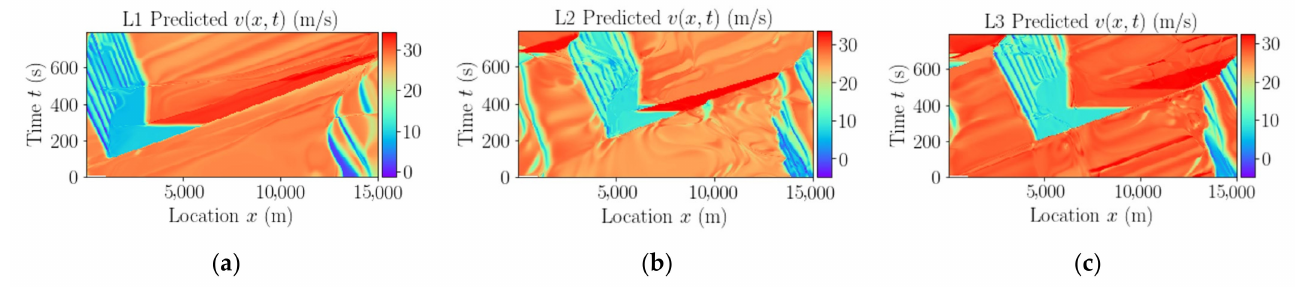
Figure 6. ( a ) Predicted traffic speed of Link L1, ( b ) predicted traffic speed of Link L2; ( c ) predicted traffic speed of Link L3.